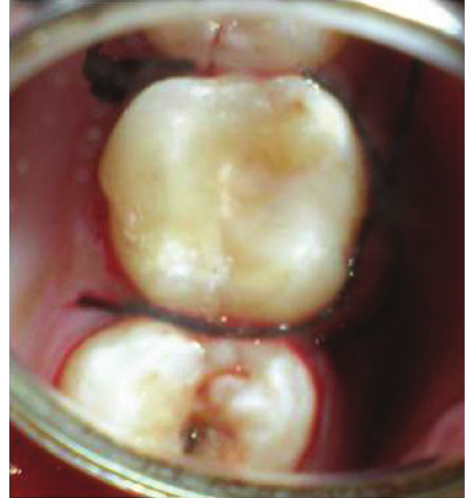
Figure 21: Closure of the surgical site with sutures in place.